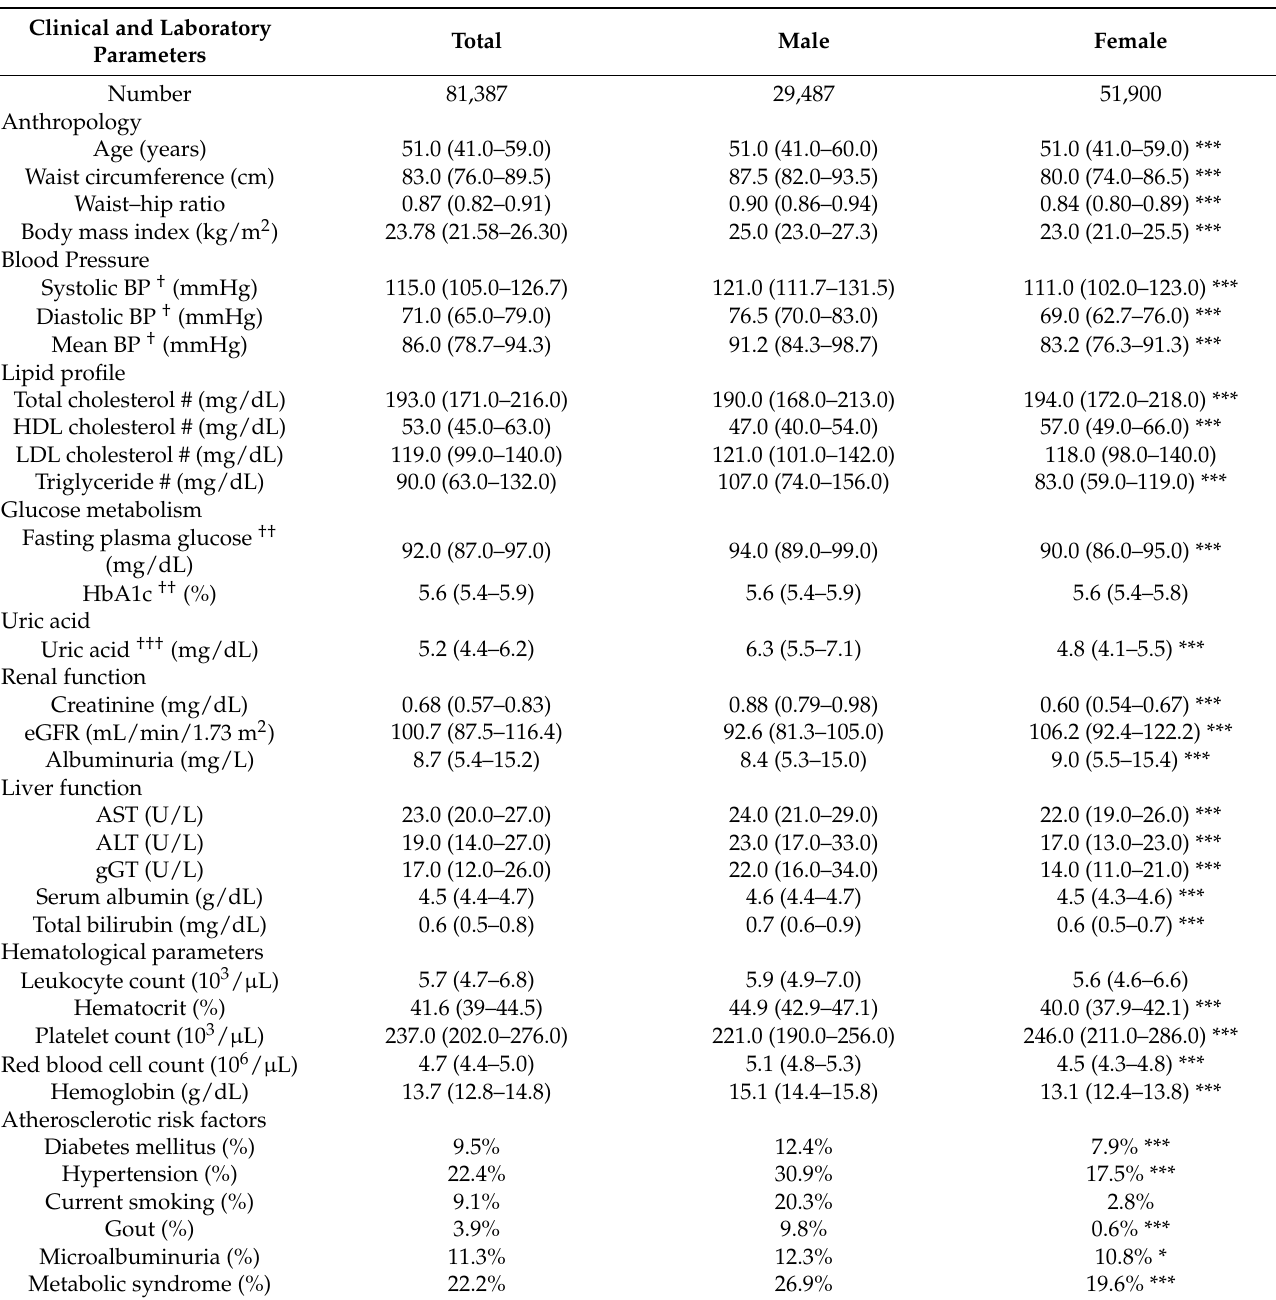
Table 1. Baseline characteristics of study patients by